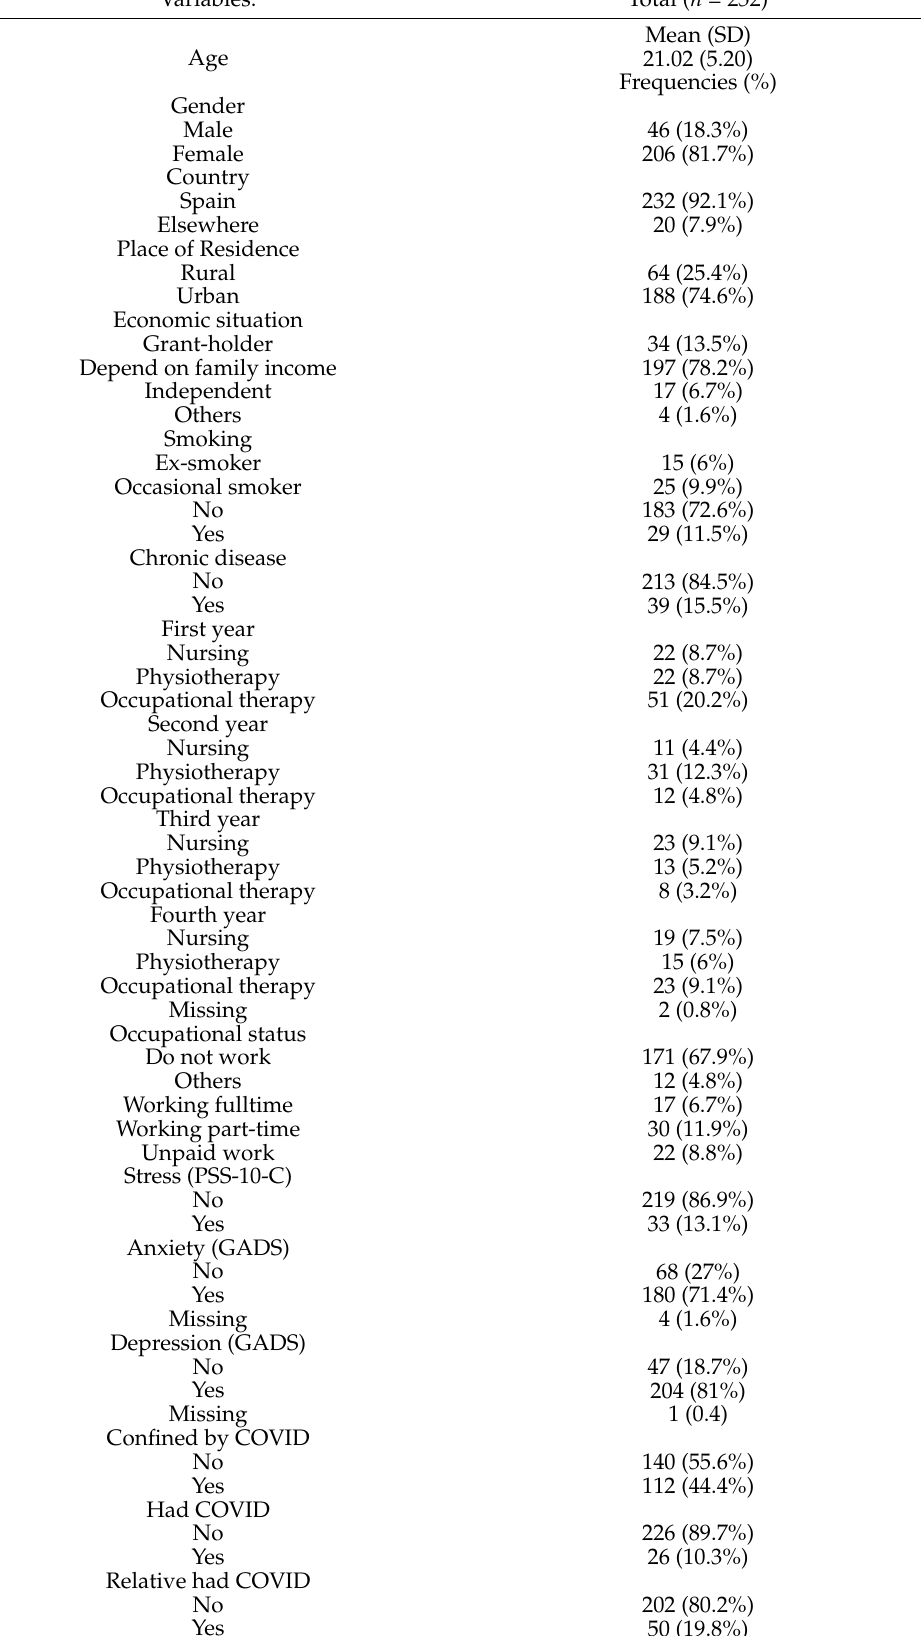
Table 1. Study sample’s socio-demographic and well-being/health